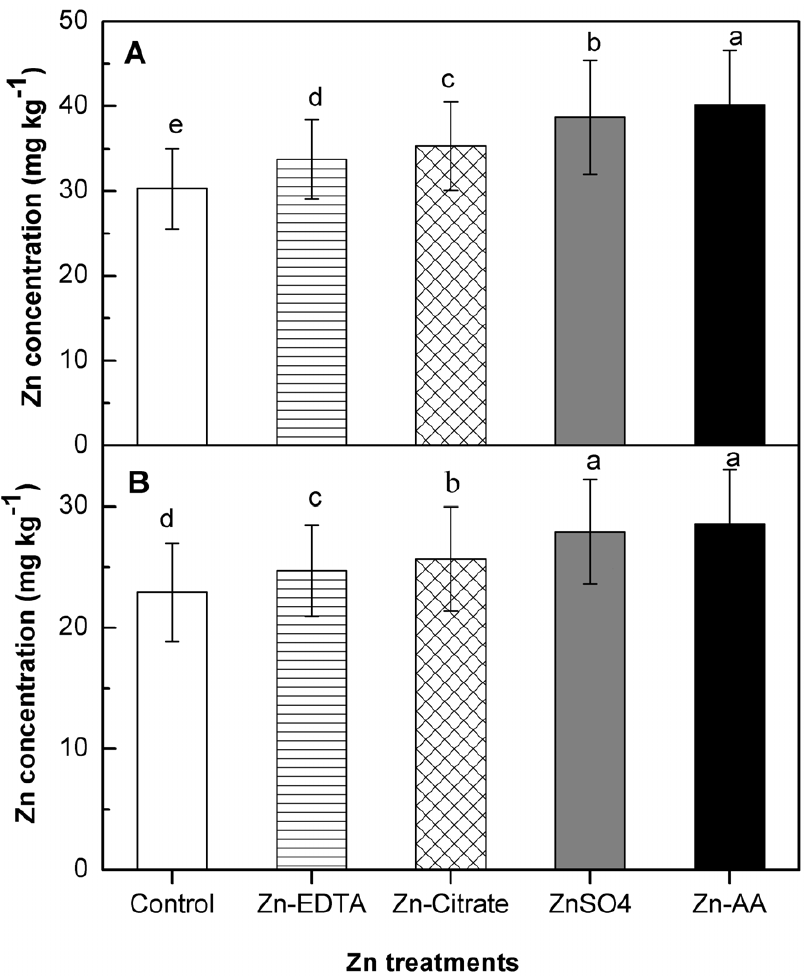
Figure 1. Effect of different forms of foliar Zn fertilization on Zn concentration in rice grain. (A) Zn concentration in brown rice. (B) Zn concentration in polished rice. Error bars indicate standard errors of the means (n=4). Different letters indicate significant difference among Zn treatments according to LSD test (P , 0.05).